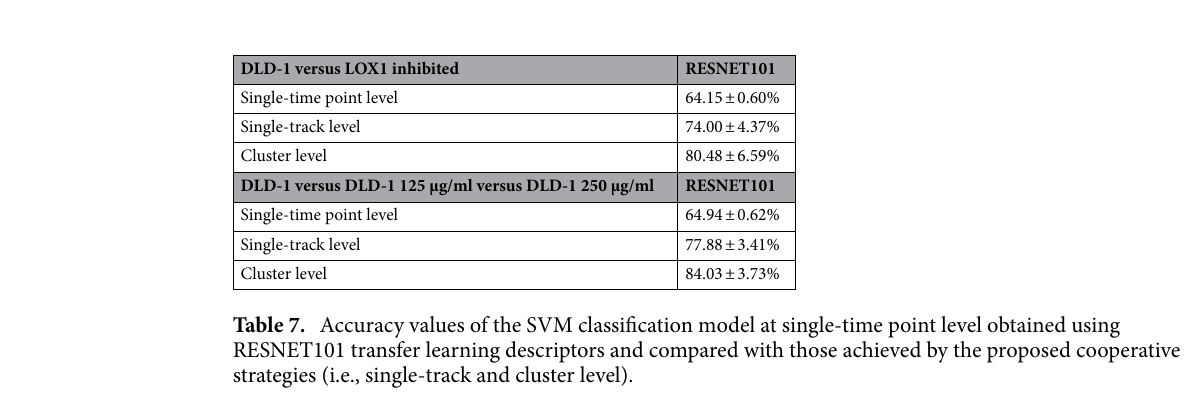
Table 6. Accuracy classification results for No Bias condition, bias value equal to 0.3 (secondo column), bias value equal to 0.5 (third column), using RESNET101 and SVM classifier.